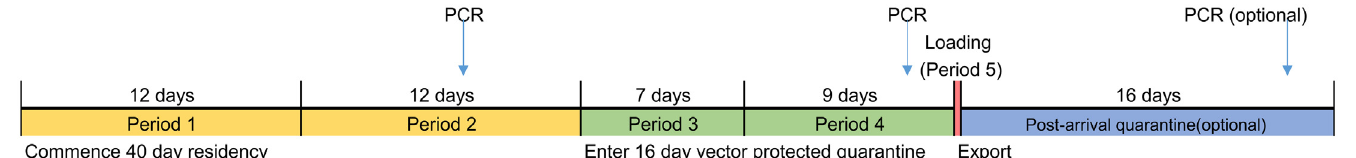
Fig 1. Timeline of risk periods for AHS infection in exported horses.